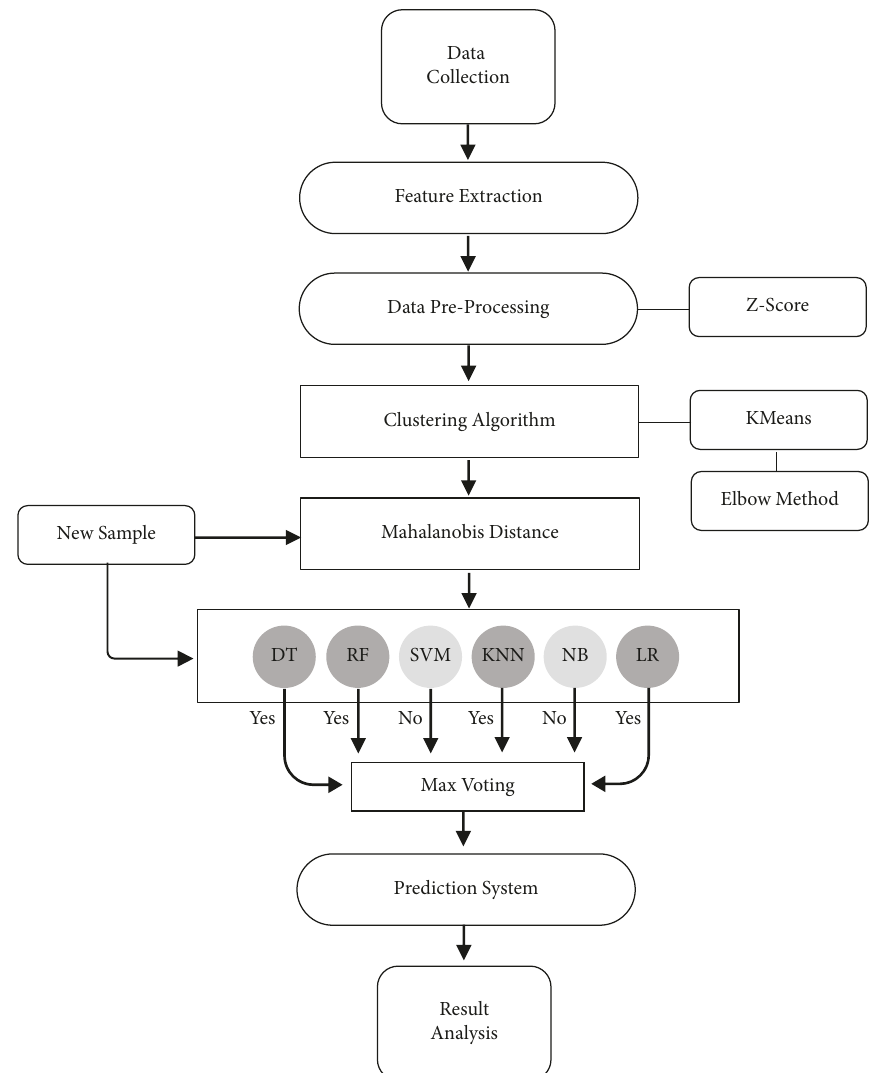
Figure 1: The flowchart of the proposed